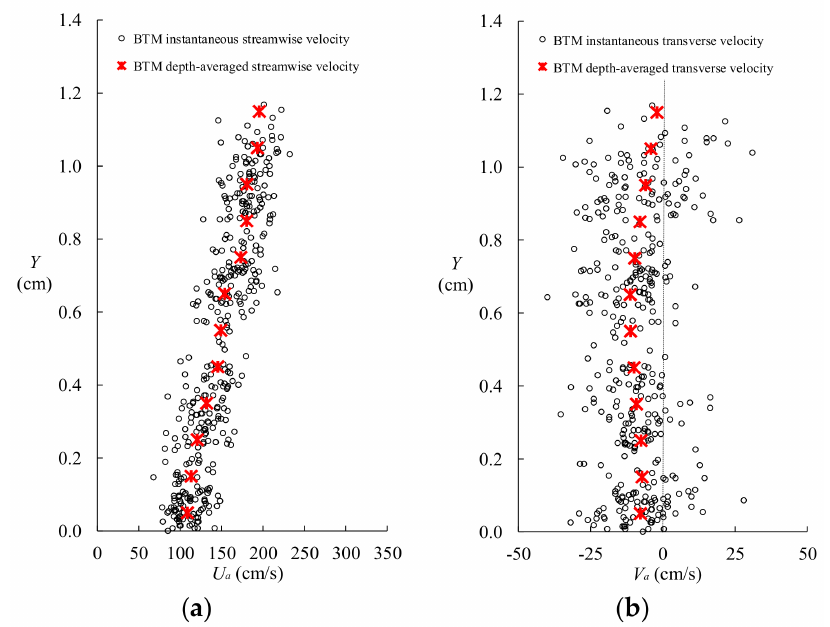
Figure 14. ( a , b ) The distribution of the instantaneous streamwise/transverse velocity of air bubbles measured by BTM, together with the counterpart of the depth-averaged streamwise/transverse